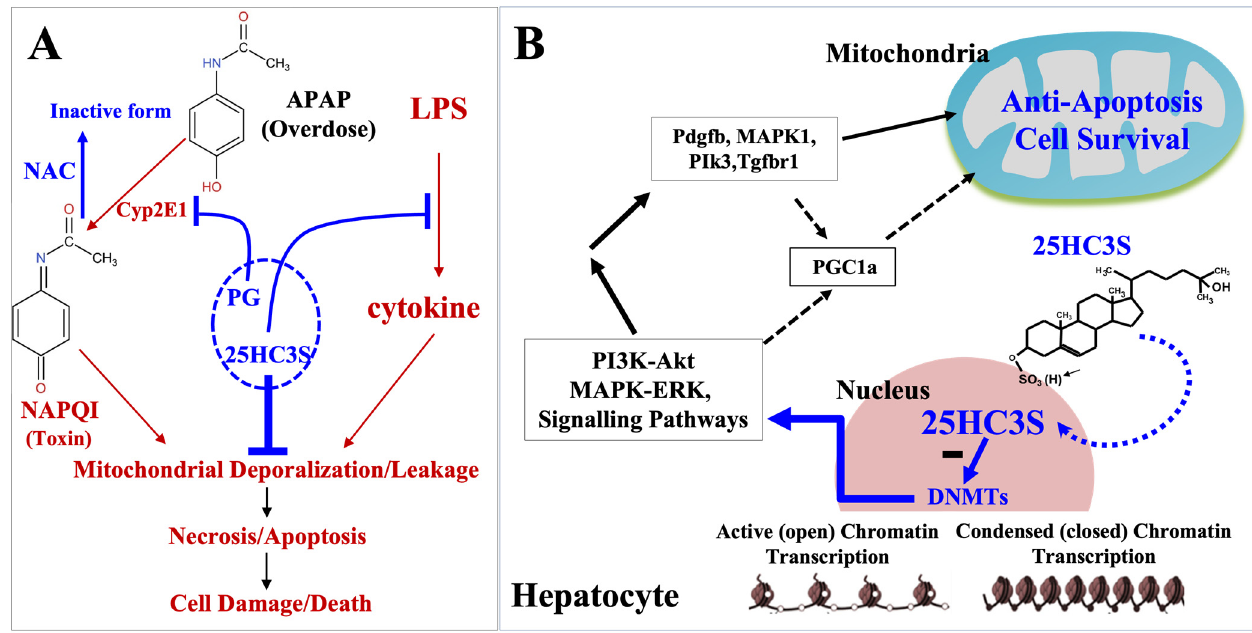
Figure 6. Schematic diagram depicting pharmaceutical mechanism. PG suppresses generation of NAPQI by inhibiting Cyp2E1 activity [55]. NAC is to promote hepatic glutathione (GSH) synthesis, which supports the detoxification of NAPQI and reduces protein binding [47,56,57]. The synergic effect of 25HC3S with NAC and PG on cell anti-apoptosis and cell survivals is shown in Panel ( A ). When 25HC3S enters to nuclear and potently inhibits DNMT-1, and 3a/3b, resulting in demethylation of 5m CpG in promoter regions of key genes involved in PI3K and MAPK signaling pathways. The increases in the expression of these key genes, Fgf11 , Pdgfa , Pdgfb , Map3k6 , Map4k4 , Ywhaz , Tgfbr , Tlr4 , Pik3cb , and Mapk1 in the MAPK and PI3K-Akt pathways lead to mitochondrial stabilization and polarization, and subsequently decreases levels of oxidants, ROS and MDA, resulting in cell survival. Effects of combination of 25HC3S with N-acetyl cysteine (NAC) in propylene glycol (PG) on generation and neutralization of toxic APAP metabolite, NAPQI ( B ); and their role in mainte- nance of mitochondrial integrity and cell survival (anti-cell death). Solid bar represents that the data have been presented in the text, and dot bar, data have been published. Arrow represents activating, and bar, blocking.